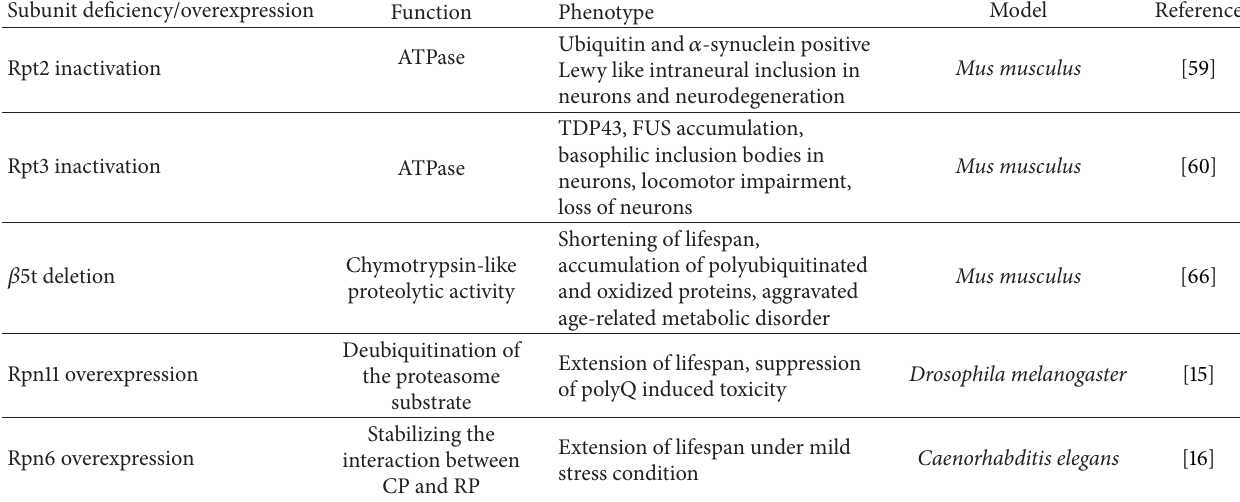
Table 1: Genetic modulation of proteasome in different models and its effect on aging and